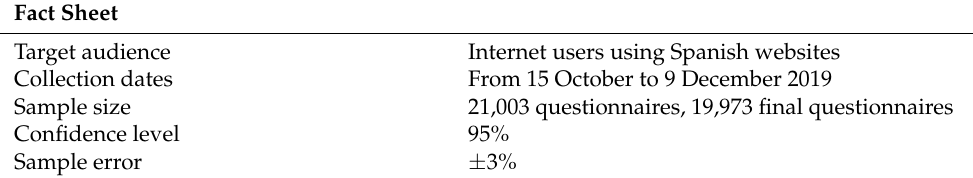
Table 1. Research fact sheet,